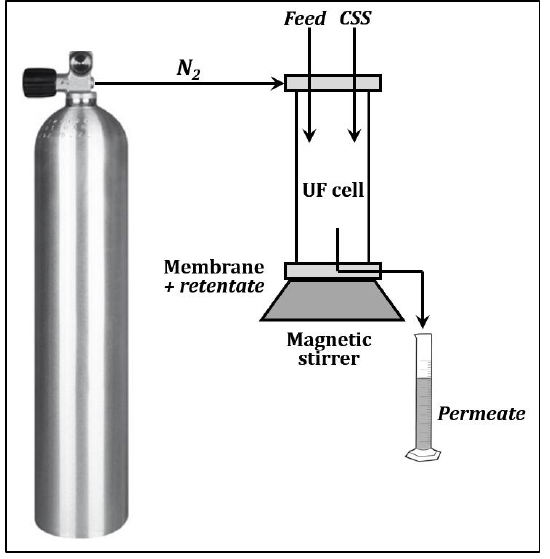
Figure 2. Schematic presentation of the laboratory-scale SAUF installation.